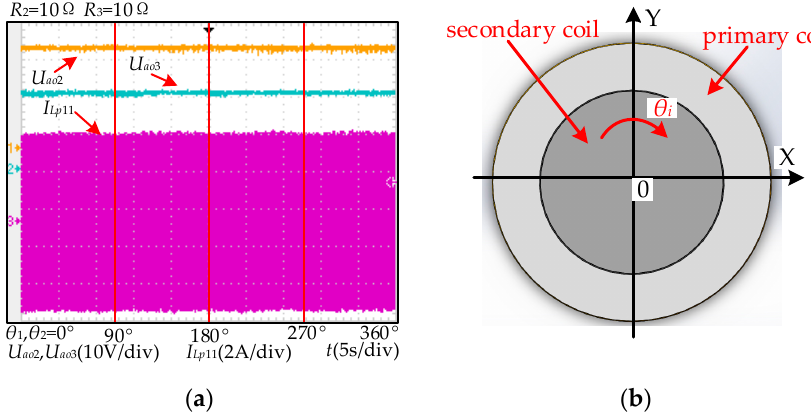
Figure 14. The variation of output voltages and input current with the rotation of secondary coils, and the rotation schematic of the secondary coils. ( a ) The variation of output voltages and input current with the rotation of secondary coils; ( b ) the rotation schematic of the secondary coils.